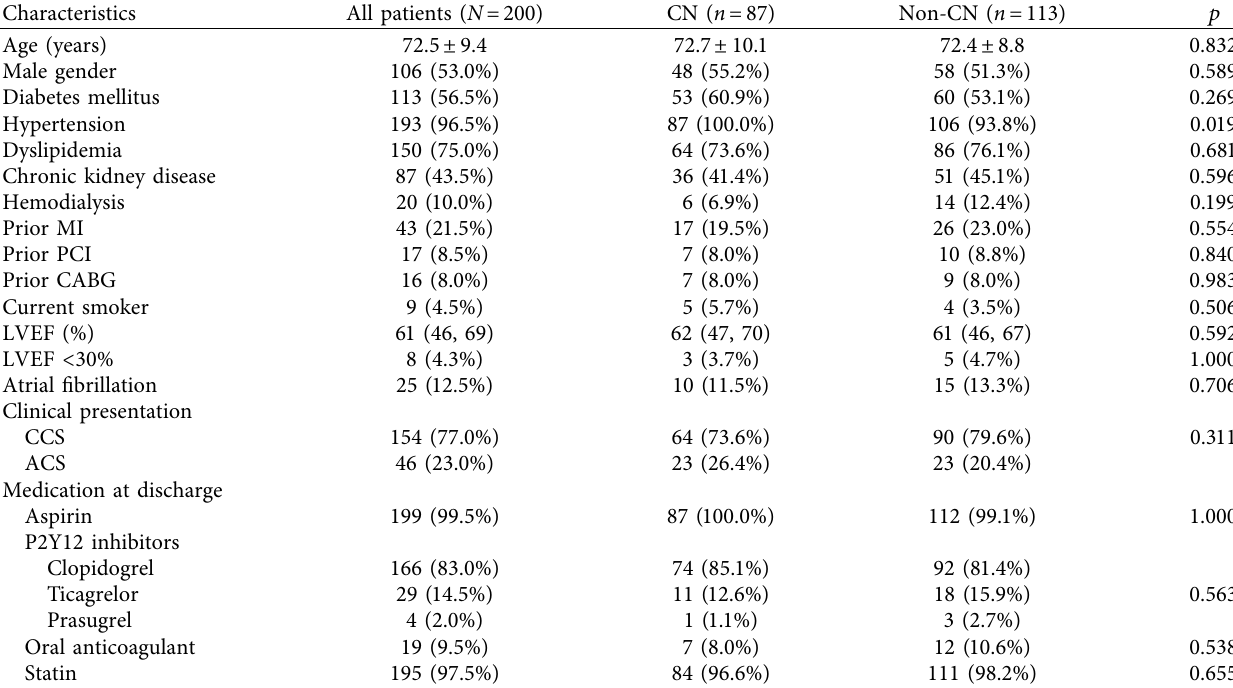
Table 1: Baseline characteristics of all patients and comparison between those with and without calcifed nodule.